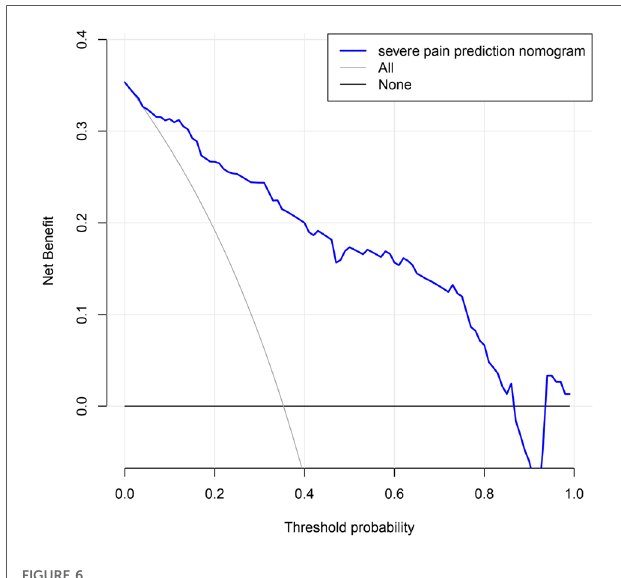
FIGURE 6 DCA curve of nomogram of modeling